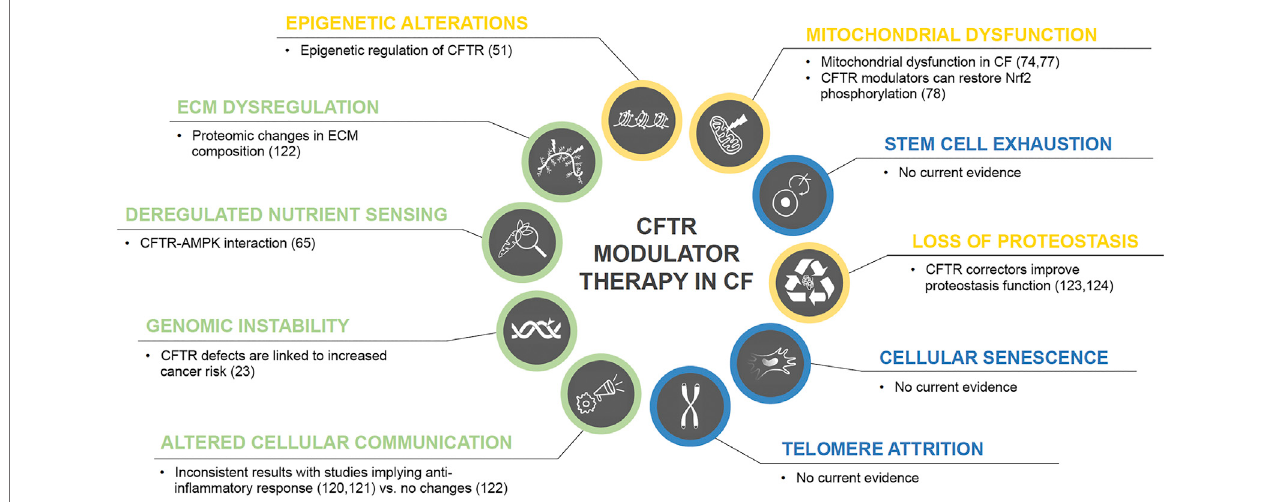
FIGURE 2 | CFTR modulator therapy in CF and potential effects on the hallmarks of aging. Color code for current level of evidence with blue (cid:1) no evidence for involvement in CF pathology, green (cid:1) weak evidence, yellow (cid:1) strong evidence.